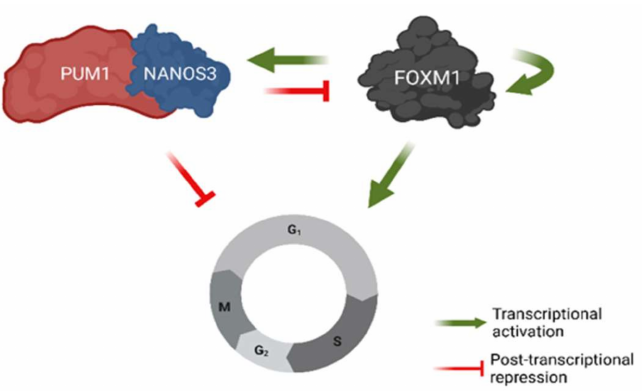
Figure 7. Model of NANOS3-PUM1-FOXM1 axis regulating G2/M phase of the cell cycle in TCam-2 cell line. Created with